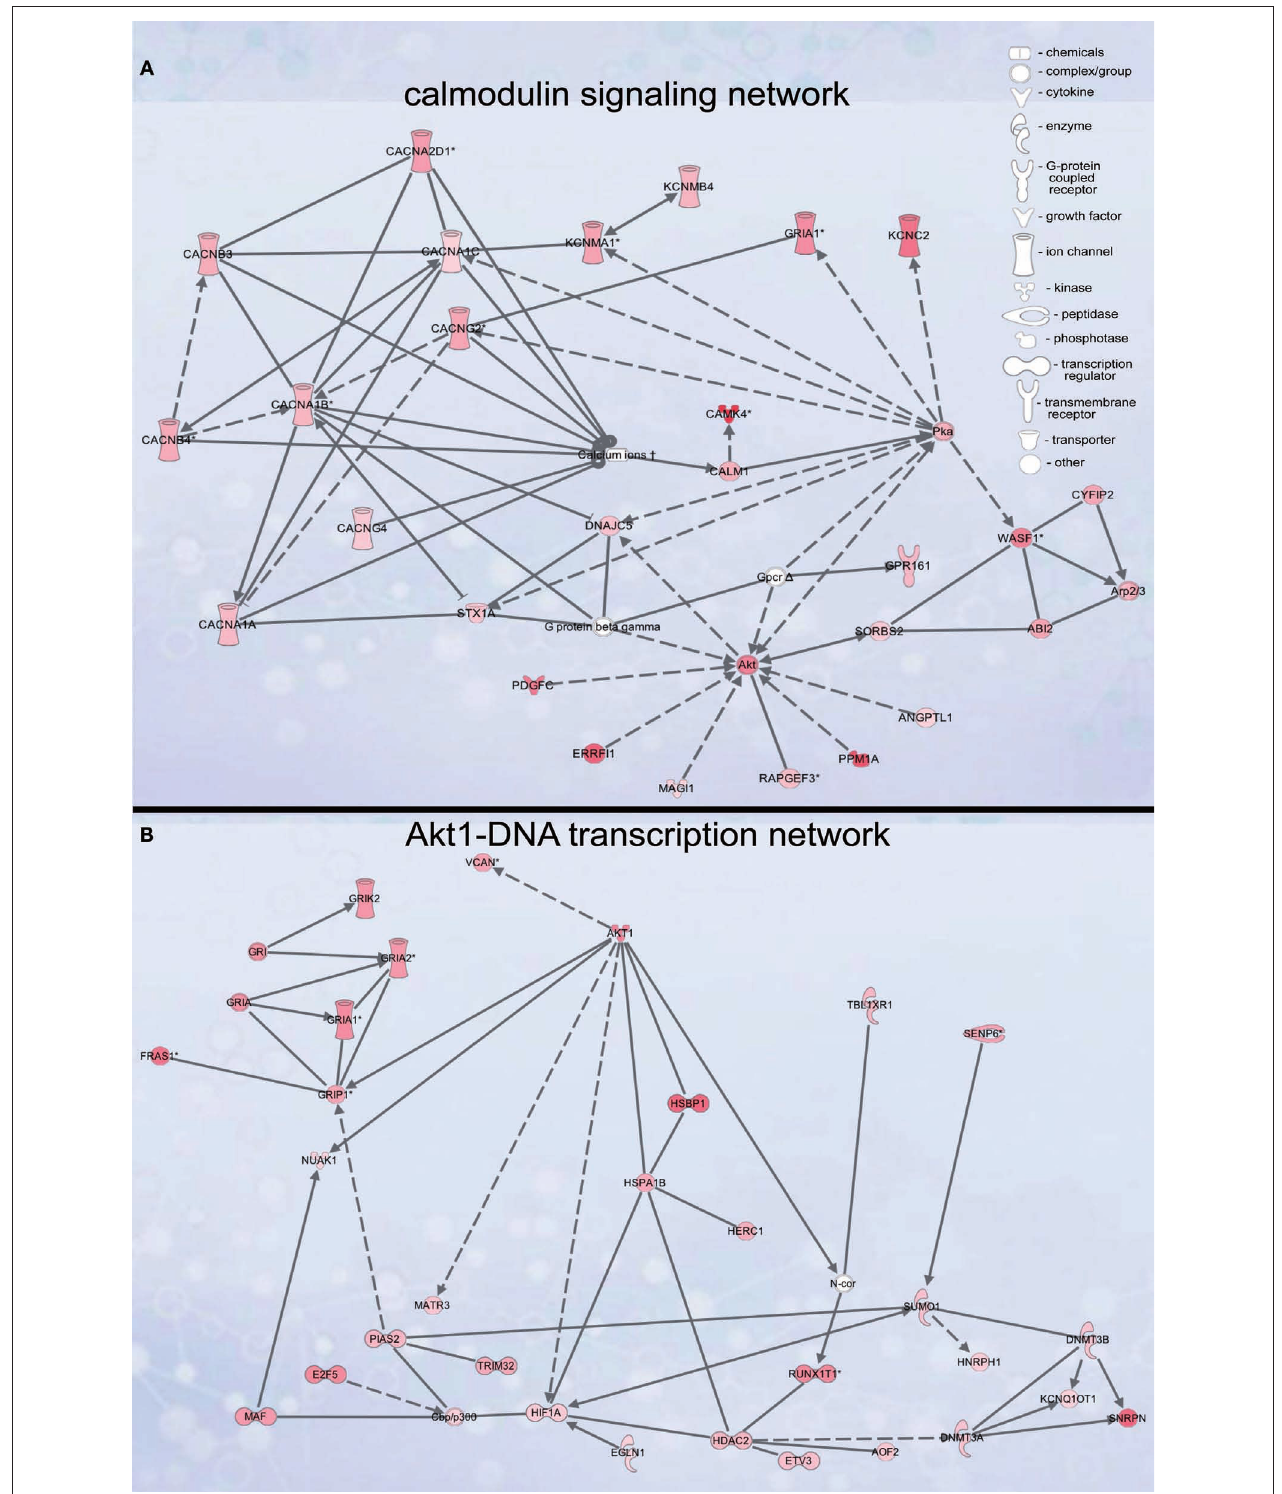
FIGURE 4 | Signaling networks upregulated in migrating neuroblasts. (A) Calmodulin-signaling network. (B) Akt1-DNA transcription network. Networks were identifi ed by Ingenuity Pathway Analysis and subsequently modifi ed using Bibliosphere, PathwayArchitect, GO and pathway databases. The intensity of the